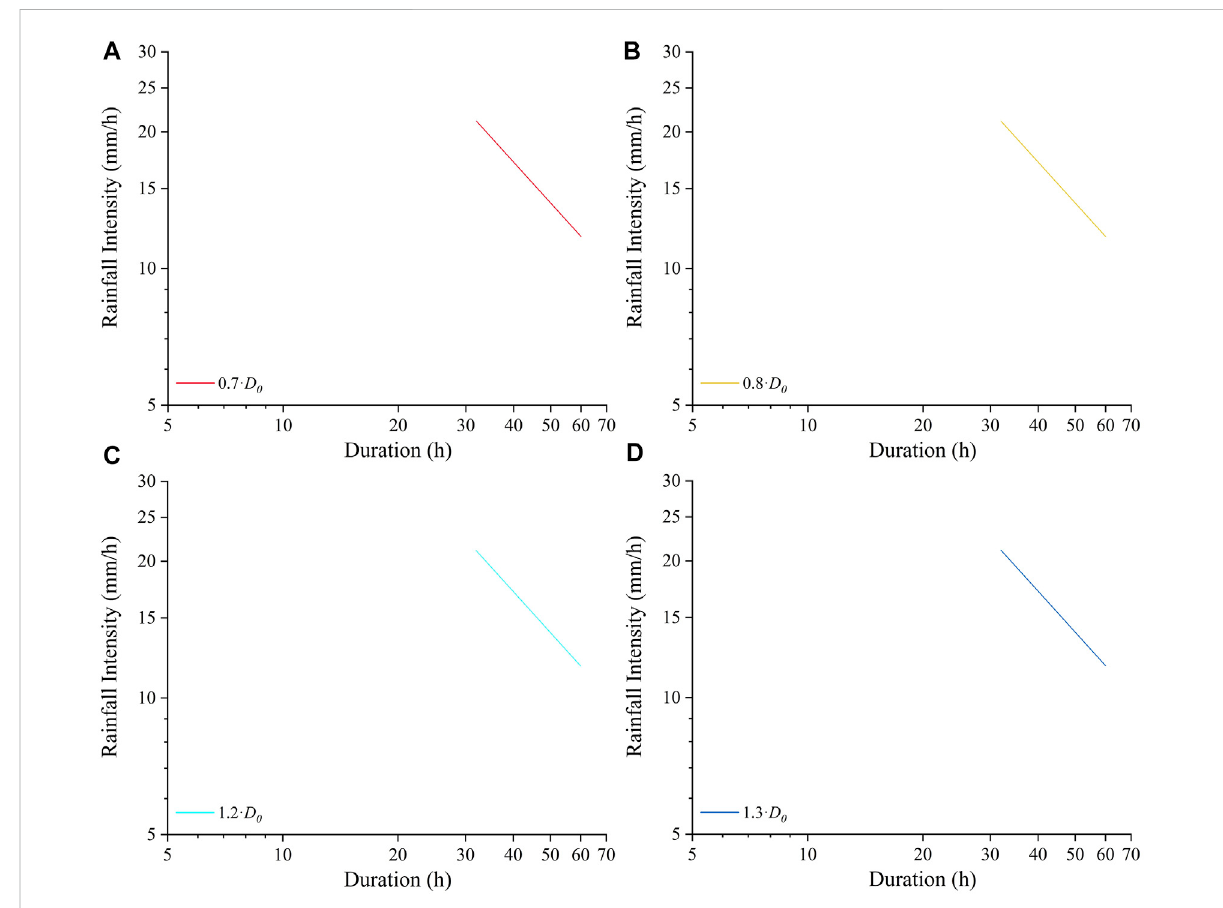
FIGURE 7 I-D thresholds de fi ned at the basin scale under the conditions: (A) 0.8 · D